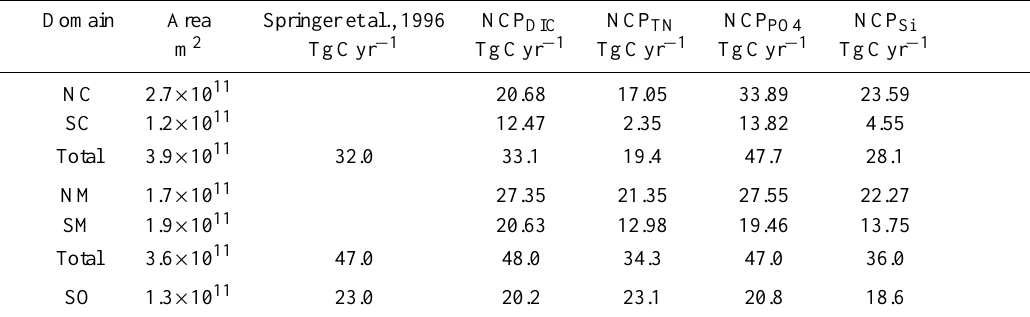
Table 5. Annual production of organic carbon based on NCP nDIC − C , integrated across the upper 30m and area of each domain compared to the annual production of organic carbon reported by Springer et al., 1996. NC indicates the northern coastal domain, SC indicates the southern coastal domain, NM indicates the northern middle domain, SM indicates the southern middle domain, and SO indicates the southern outer